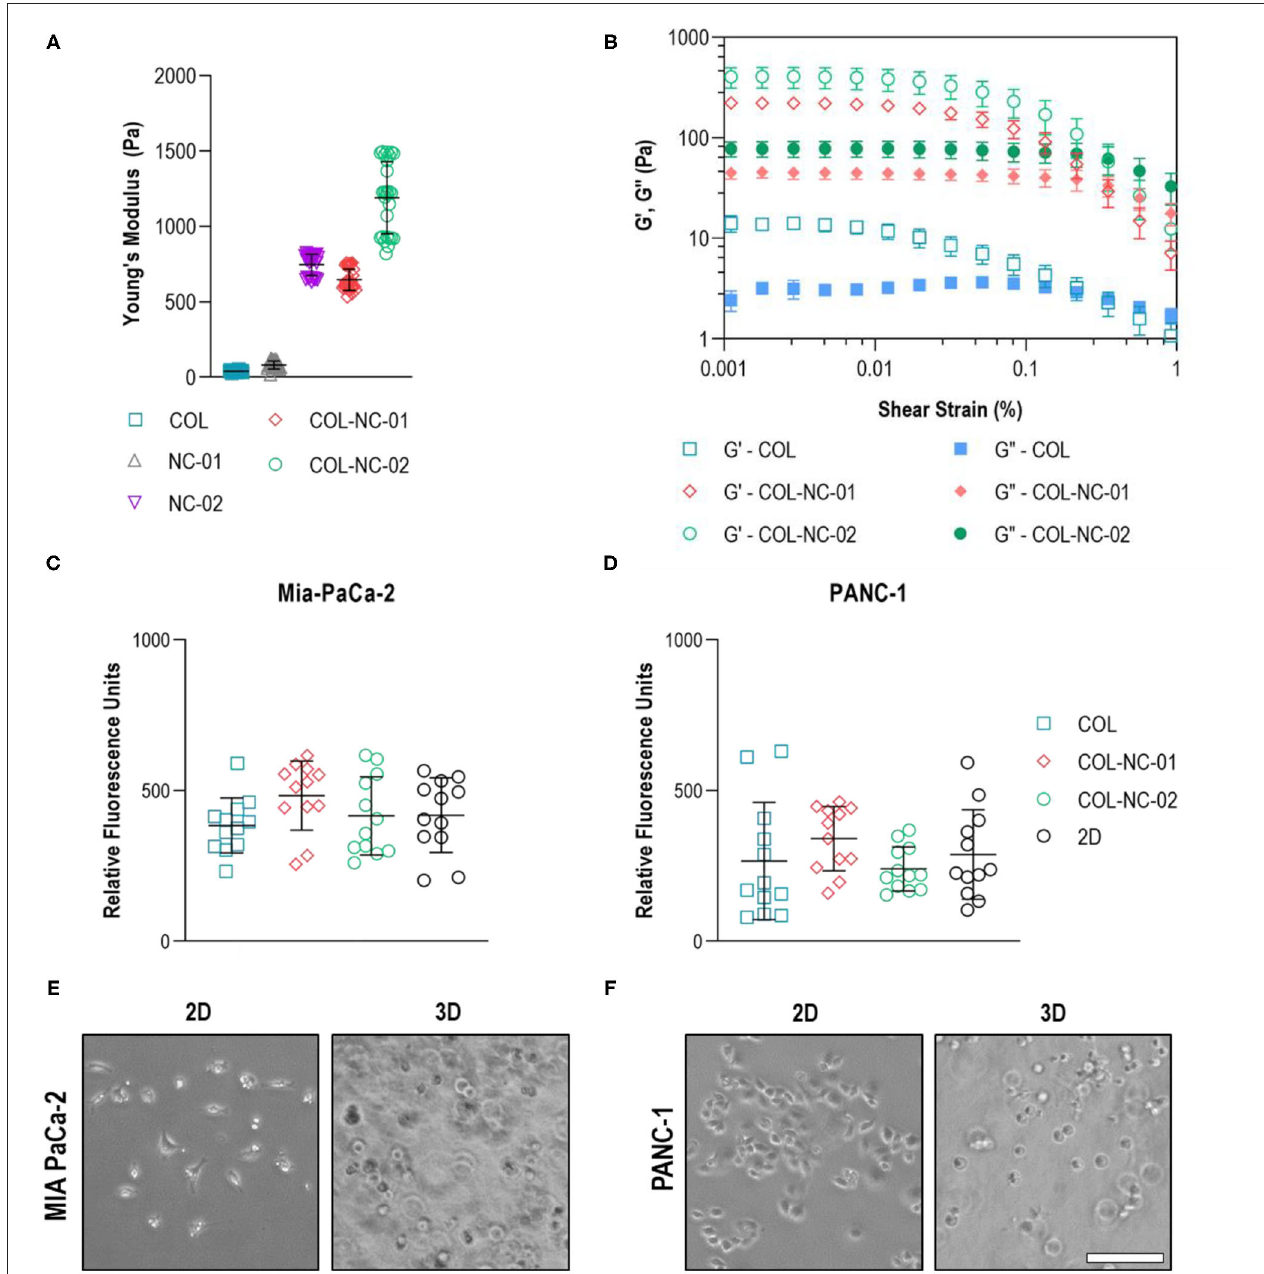
FIGURE 2 | Hydrogel and cell characterisation. (A) The reinforcing effect of nanocellulose and collagen on the mechanical properties of the hydrogels represented by the Young’s modulus. (B) Oscillatory strain sweep measurements indicated that both storage and loss moduli of collagen-nanocellulose hydrogels rose by more than 10-fold, whilst the yield point was unchanged. G’, storage modulus; G”, loss modulus. The metabolic activity of MIA PaCa-2 (C) and PANC-1 (D) cells was unchanged when grown embedded in different hydrogels and as 2D monolayers. MIA PaCa-2 cells (E) had a spindle-shaped morphology in 2D and PANC-1 cells (F) acquired a polygonal shape, while both cell types were round in 3D. Scale bar = 100 µ m. Results shown represent independent experiments performed in triplicates ( n = 3, error bars = SD). COL, collagen; NC, nanocellulose; COL-NC-01, collagen-nanocellulose at 0.1 wt%; COL-NC-02, collagen-nanocellulose at 0.2 wt%.